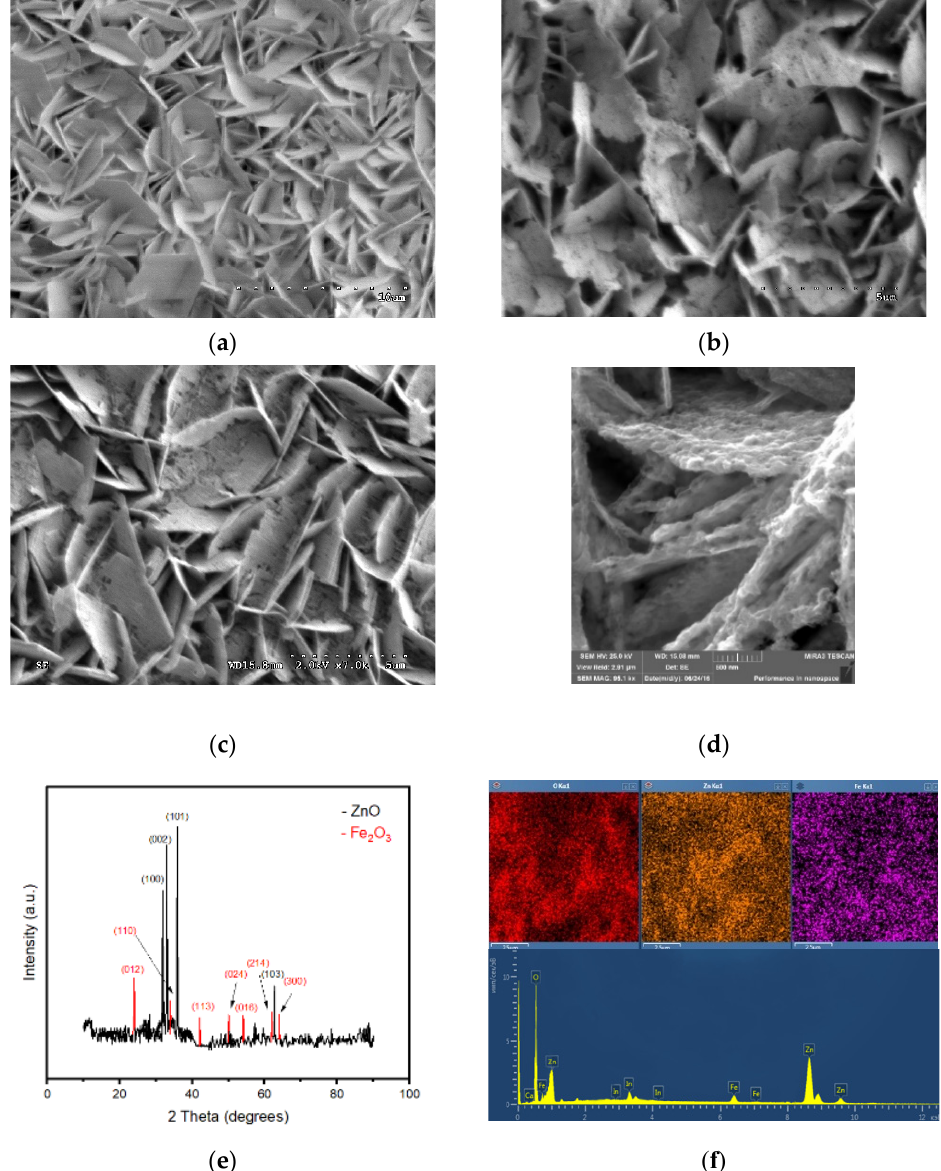
Figure 2. Characterization of obtained ZnO NS and ZnO NS/Hematite: ( a ) SEM ZnO NS; ( b ) ZnO NS/Hematite1; ( c ) ZnO NS/Hematite2; ( d ) ZnO NS/Hematite3; ( e ) XRD pattern of ZnO NS/Hematite3; ( f ) EDX analysis of ZnO NS/Hematite3.